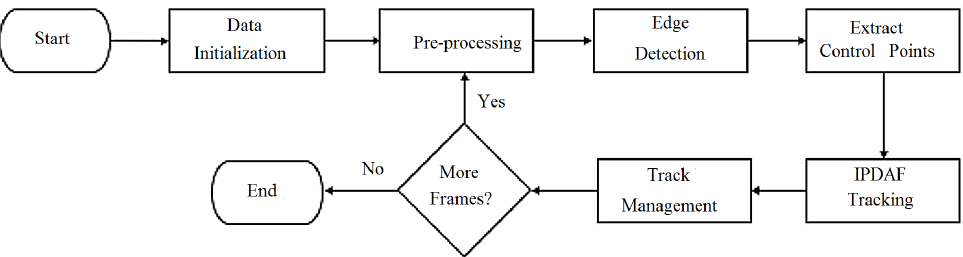
Figure 2. The flowchart of the proposed